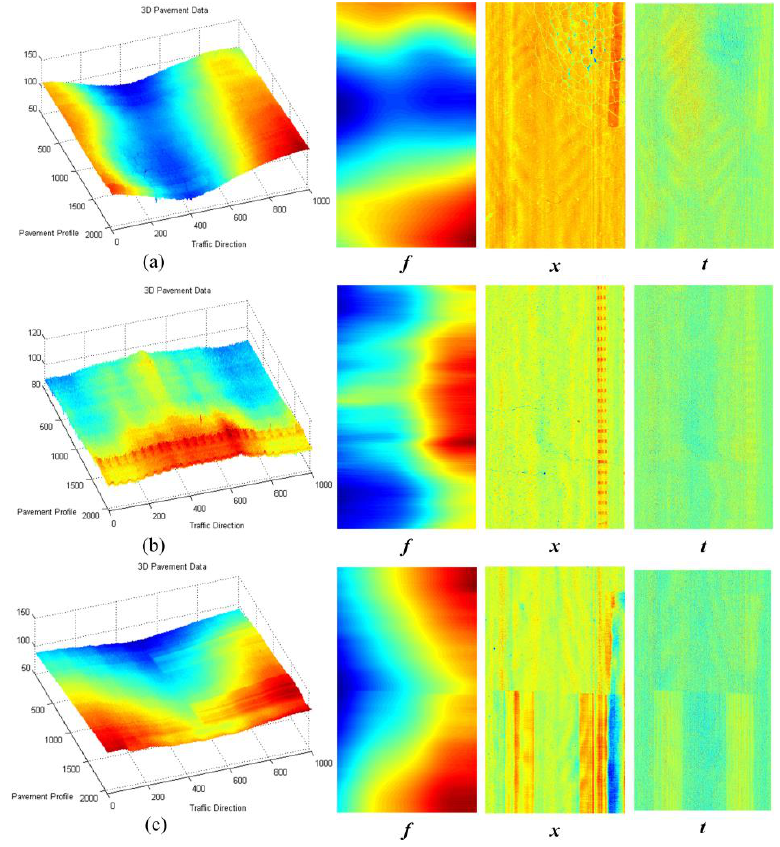
Figure10. Illustration of 3D pavement data and corresponding decomposition results. Figure 10. Illustration of 3D pavement data and corresponding decomposition